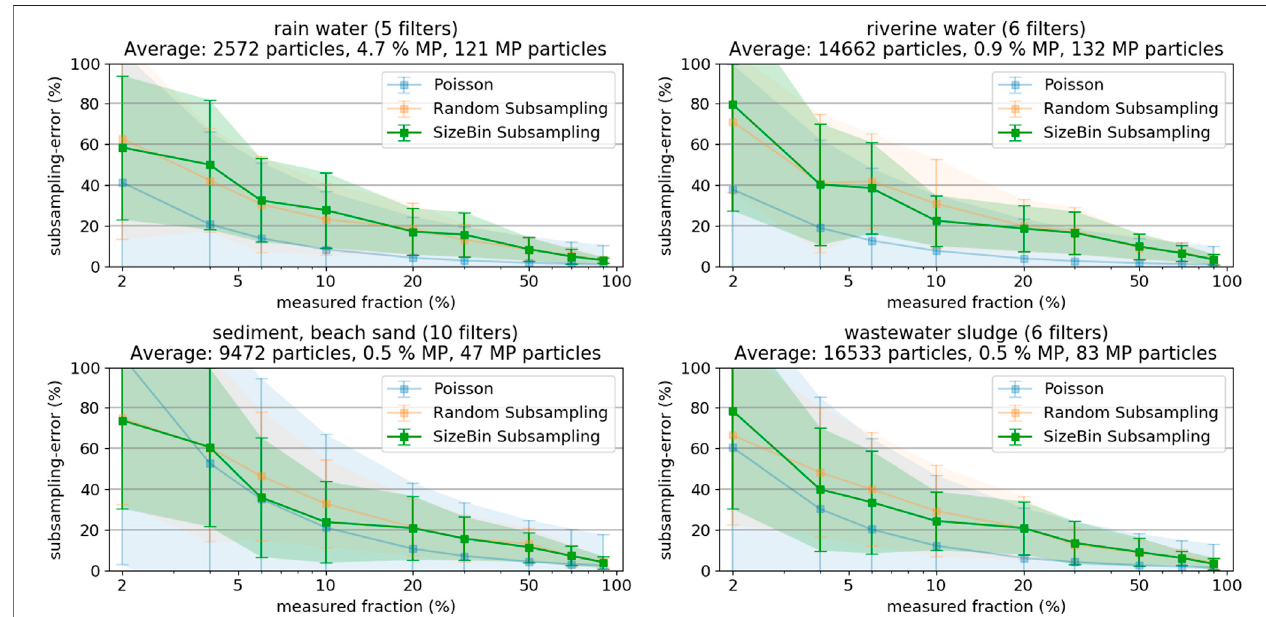
FIGURE 4 | Subsampling-errors and their standard deviation of Random and SizeBin Subsampling, as derived from the different sample types (rainwater, river water, sediment, and sludge). As reference, the theoretical subsampling-error derived from the Poisson